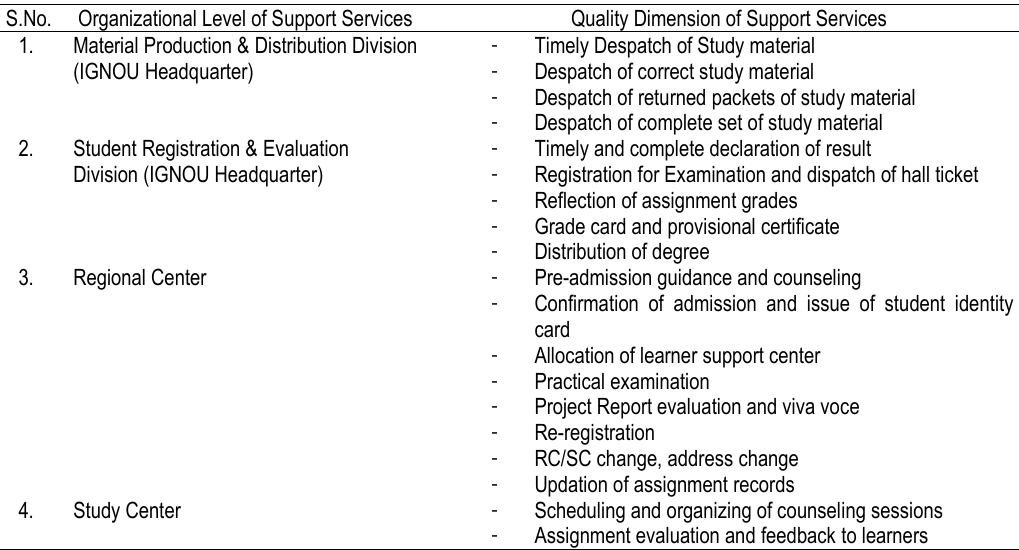
Table 4. Quality Dimensions of Support